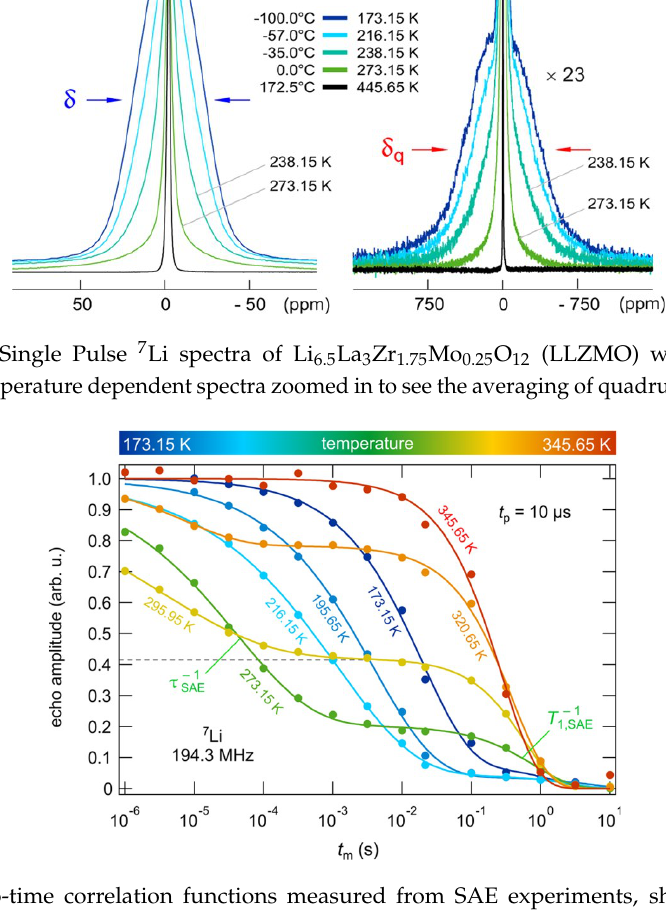
Figure 18. (Left) Single Pulse 7 Li spectra of Li 6.5 La 3 Zr 1.75 Mo 0.25 O 12 (LLZMO) with temperature. (Right)